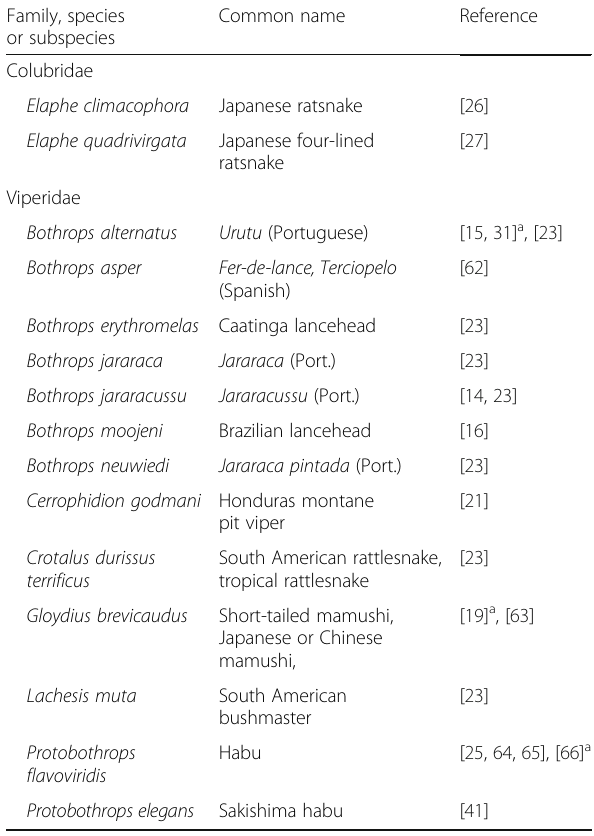
Table 1 Snake blood PLA 2 inhibitors in the alpha structural class (sb α